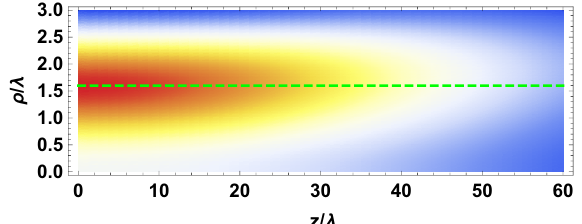
Figure 1. Potential energy W( r , z ) for parameters: λ = 1070 nm, a = λ /15, n p = 1.45, n = 1.33,